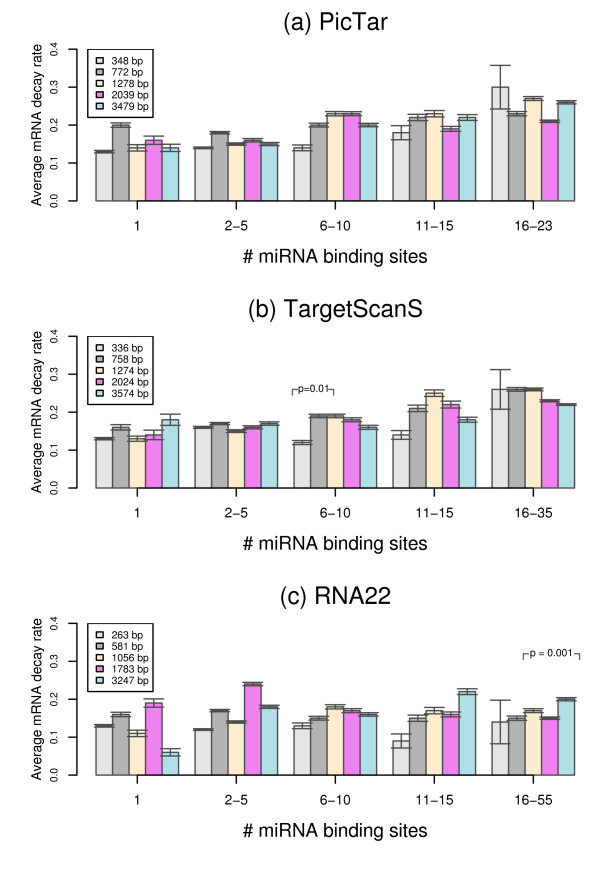
Relationship between the length of 3'UTR and mRNA decay rate. Variation of mRNA decay rates of different 3'UTR length groups for miRNA target genes with different miRNA target sites predicted from PicTar (a), TargetScanS (b), and RNA22 (c). The median length of each 3'UTR length group is shown in the legend boxes. The degree of the mRNA decay rate differences between the low, median, and high 3'UTR length groups in each miRNA binding site groups was estimated by Wilcoxon rank sum tests and the significant ones are depicted in p-values.